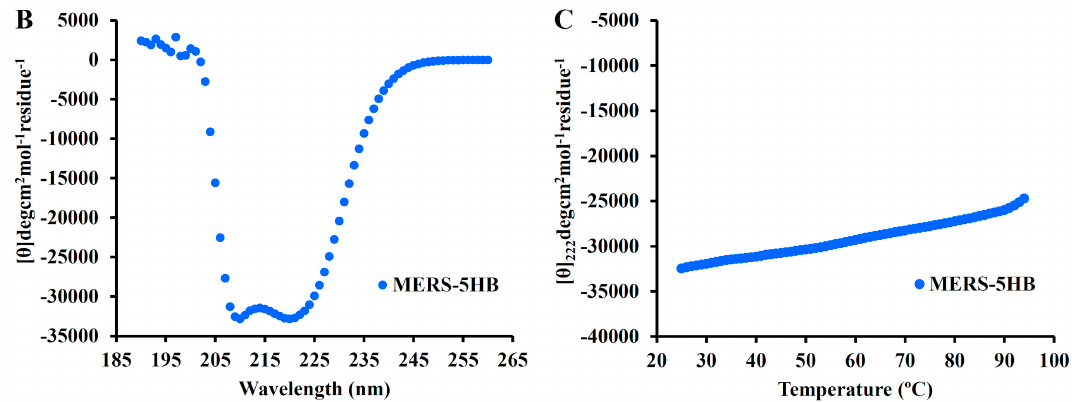
Figure 5. Biophysical characterization of MERS-5HB. ( A ) SEC analysis of MERS-5HB. The elution volume of MERS-5HB was 10 mL indicating that MERS-5HB existed as monomer. ( B ) Secondary structure of MERS-5HB in phosphate buffer, pH 7.4. Circular Dichroism (CD) spectra illustrates double minima at 208 nm and 222 nm indicating that MERS-5HB adopted a typical α -helix structure. ( C ) Thermal denaturation of MERS-5HB. CD signals at 222 nm were recorded from 25 °C to 95 °C with a scanning rate of 1 °C/min.